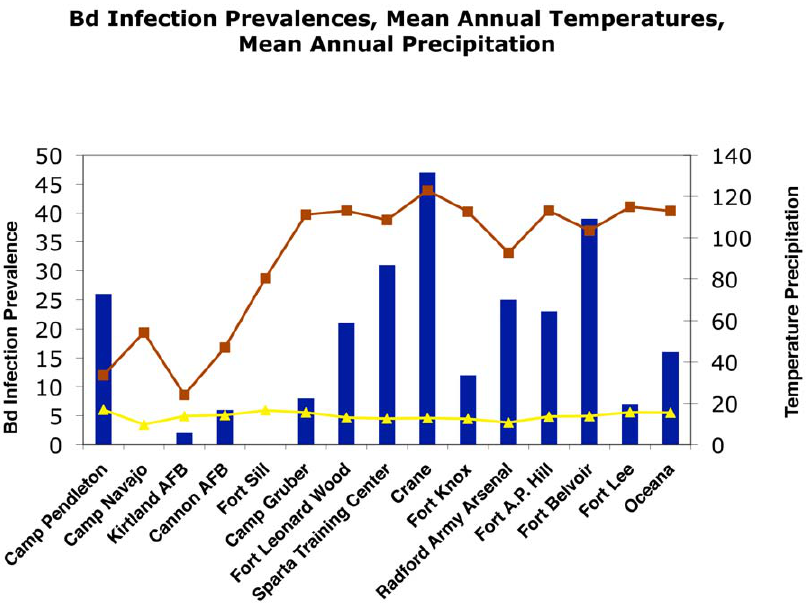
Figure 2. Prevalence (percentage) of Bd -positive samples by installation. Bases are arranged from west to east in the order they appear in Figure 1. Right side y-axis indicates both mean annual temperature ( u C, yellow line) and mean annual precipitation (cm, red line). Note the generally low percentage of positive samples from the arid western installations. doi:10.1371/journal.pone.0022211.g002 PLoS ONE |